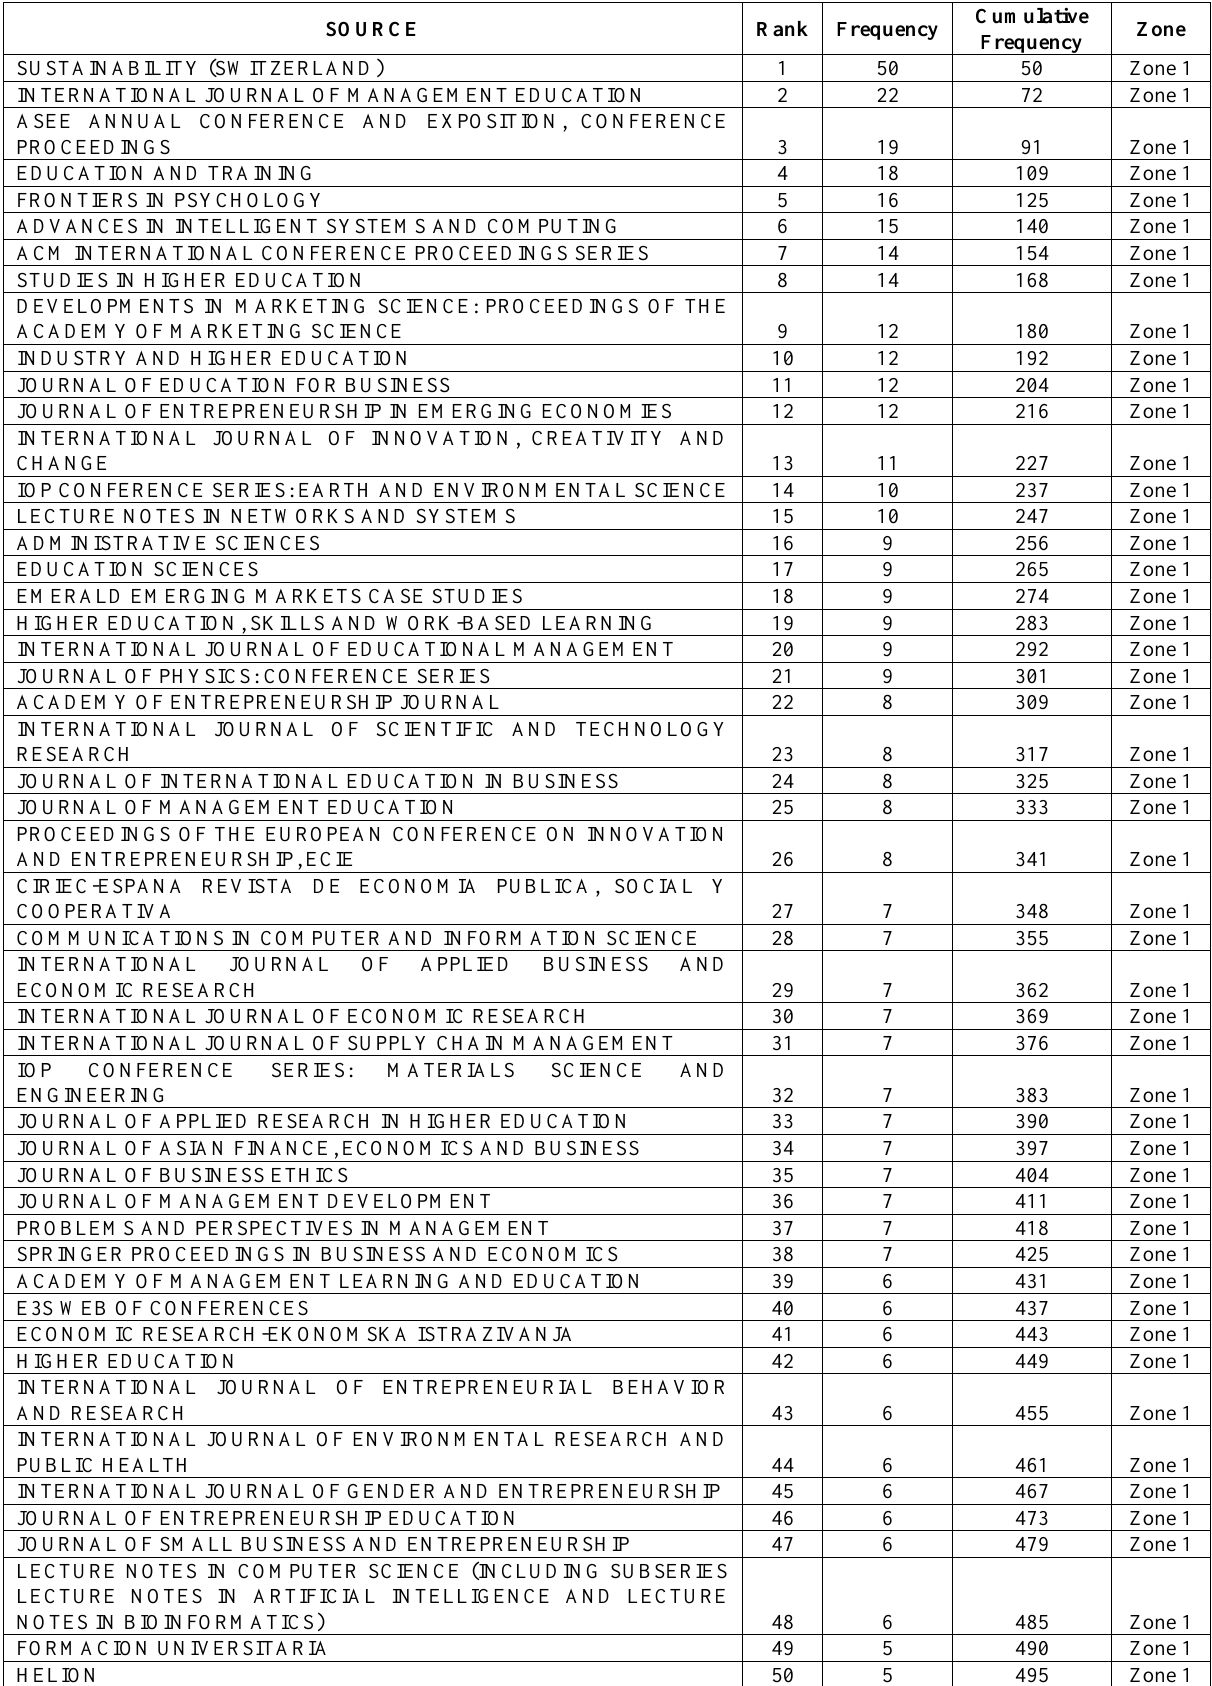
Table 2. Source Clustering through Bradford’s